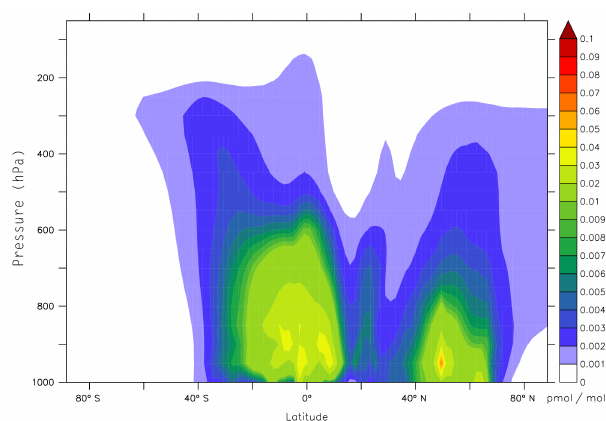
Figure 14. Model-calculated zonal, annual average of carbon sub- oxide mixing ratios in pmolmol − 1